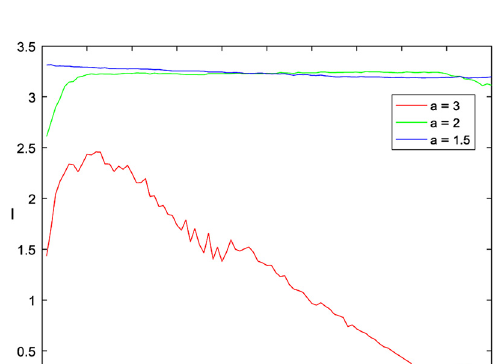
Figure 4. Degree of economic specialization a = 1.5